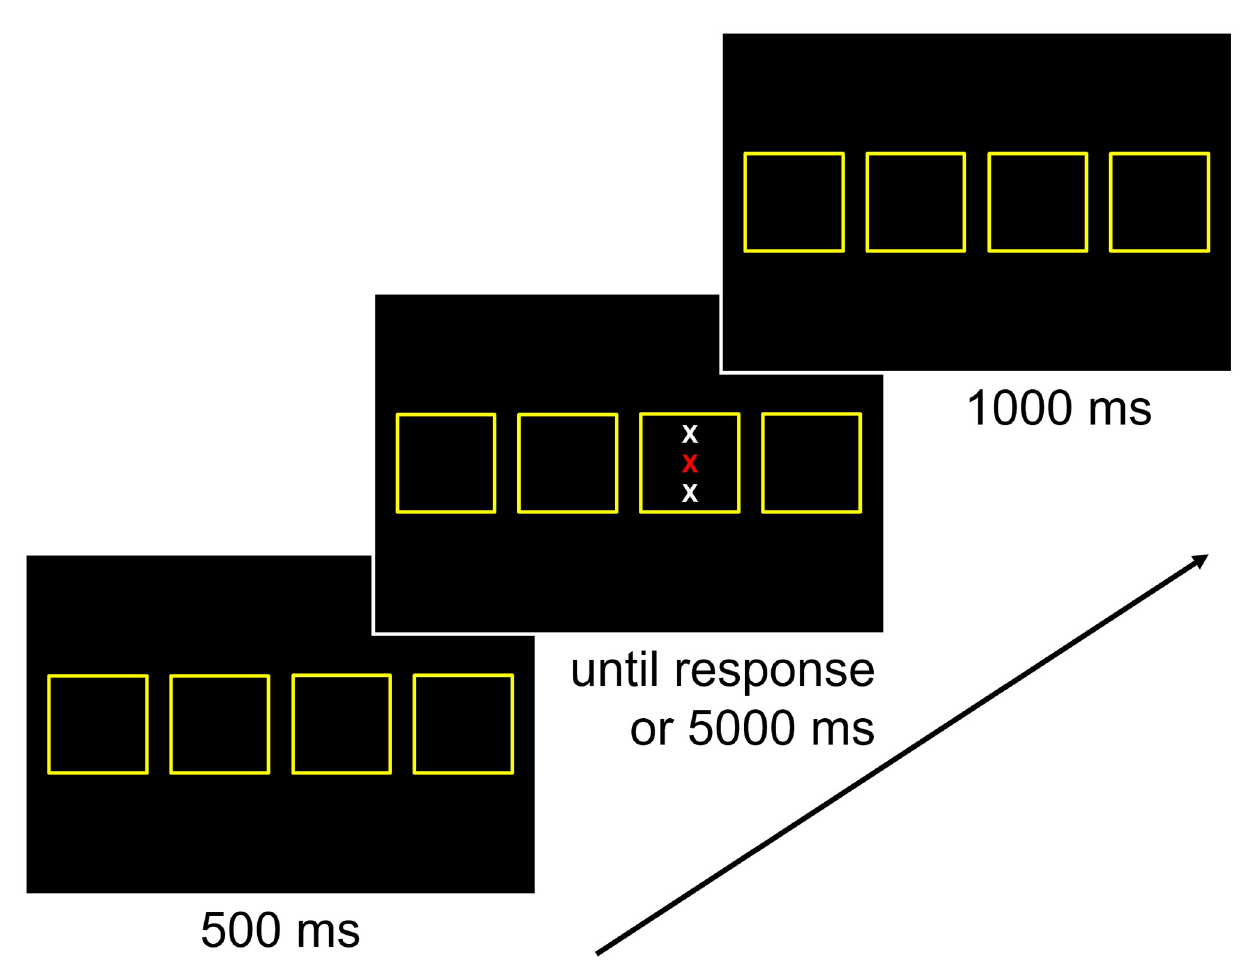
Fig 7. Experiment 2: Example of one trial sequence in the position “Simon horizontal–flanker vertical”. Participants were asked to indicate the color of the central letter while ignoring the flanking letters and their location on the screen. They used the four response keys y , v , m , and - , which were mapped to the colors red, brown, violet, and white,